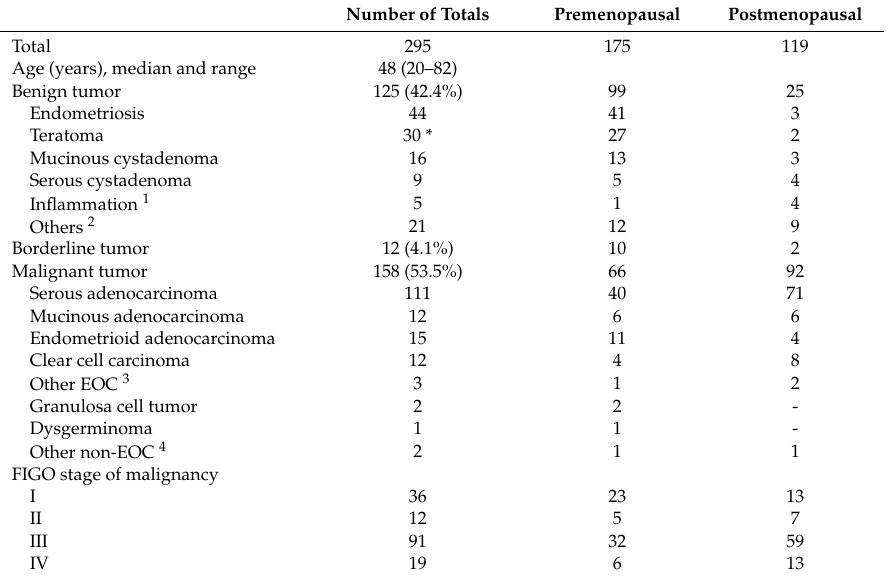
Figure 1. Process of the differential diagnosis modeling between ovarian cancer (OC) and benign tumor in this study. AUC, area under the receiver operating characteristic curve; LASSO, Least Absolute Shrinkage and Selection Operator. Table 1. Clinical and demographic characteristics of the study patients.